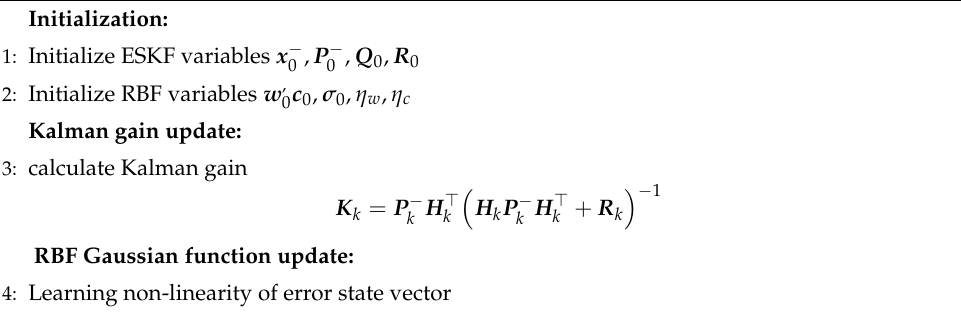
Algorithm 1 RBF-ESKF multi-sensor fusion for underwater